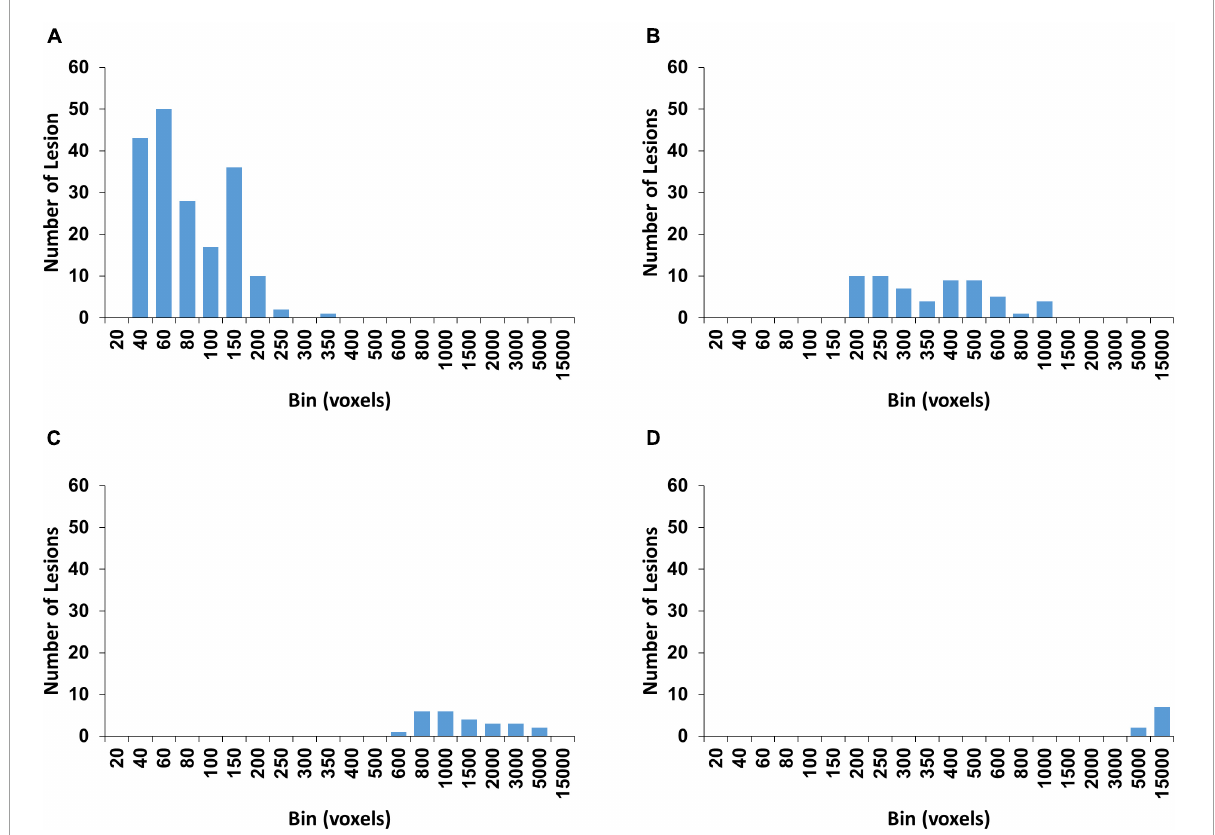
FIGURE3 The four clusters with the histogram of the WMH3D volume size distribution are determined by gap statistic. The numbers of WMH3D in each cluster (A – D) are 187, 59, 25, and 9, respectively.